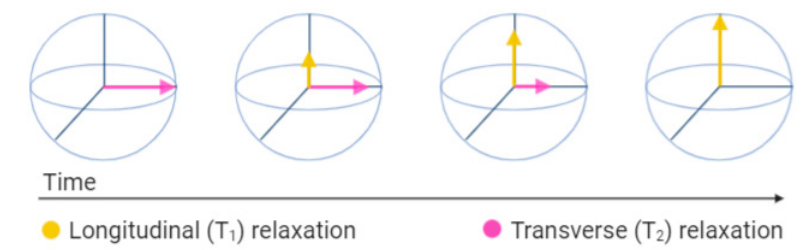
Figure 2. Representation of the longitudinal (T 1 ) and transverse (T 2 ) magnetization vectors after the radiofrequency pulse (RF) is turned off.